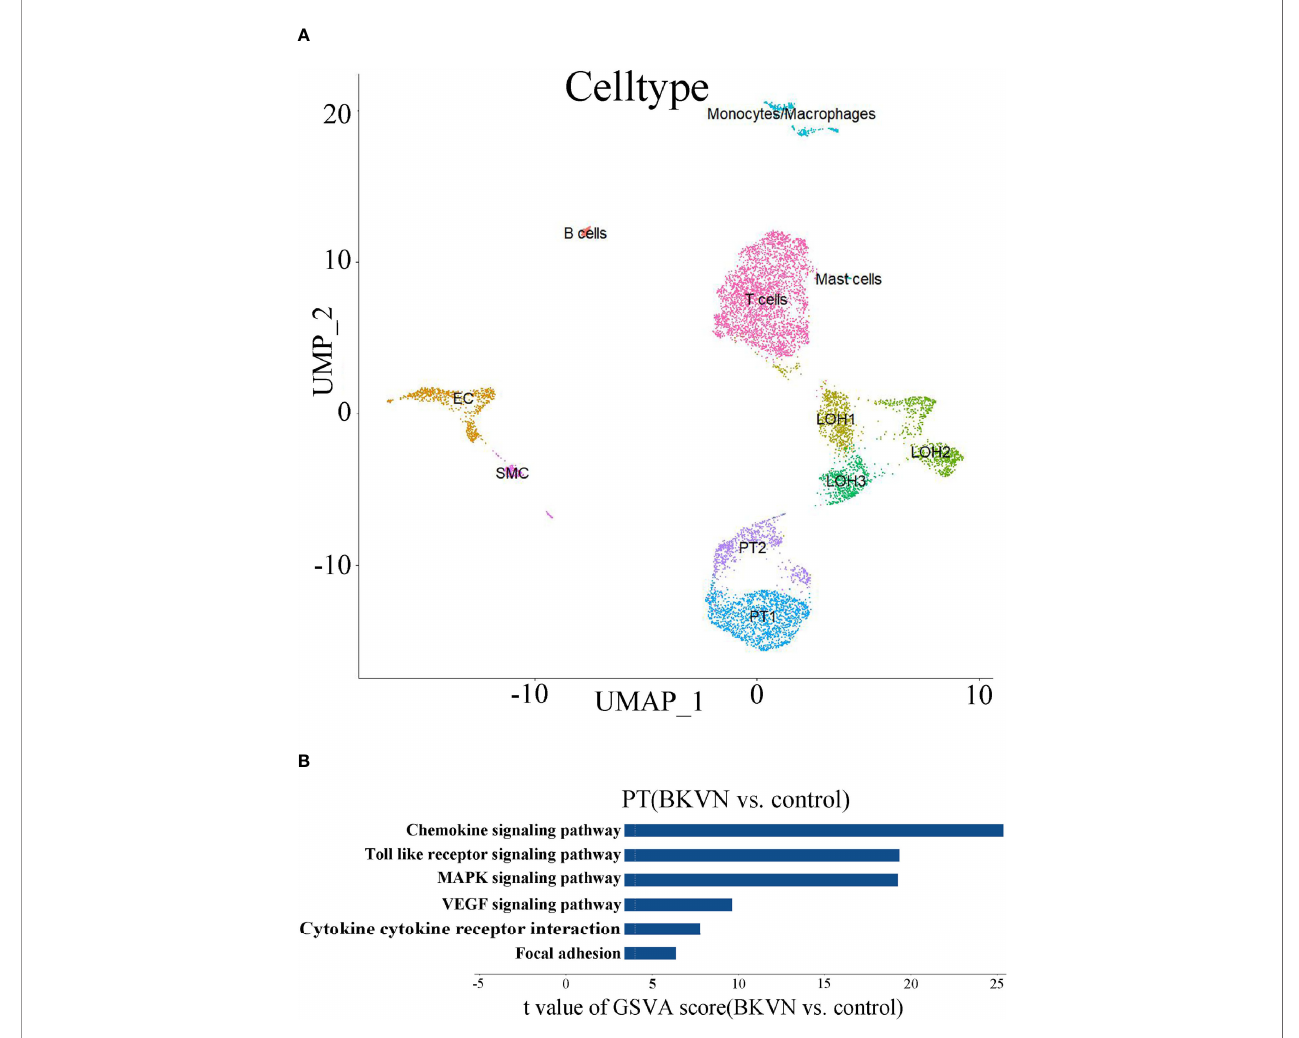
FIGURE 5 | scRNA analysis of PT in the kidney. (A) UMAP plot of cell clusters identi fi ed on the basis of the expression of highly variable genes (at a resolution of 0.25). (B) Bar plot of the differences in six pathways between BKPyVAN and healthy transplanted kidney (n = 3,275 and 5,401 cells from six samples, respectively). Resulting from the GSVA score comparison tests comparing BKPyVAN with healthy